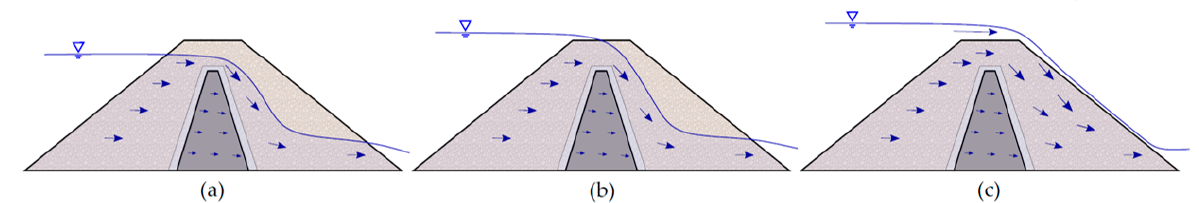
Figure 2. ( a ) Overtopping of the core with throughflow. ( b ) Partial overtopping of the crest with throughflow. ( c ) Com- plete overtopping of the crest with throughflow and overflow of rockfill dams. Modified from [10].